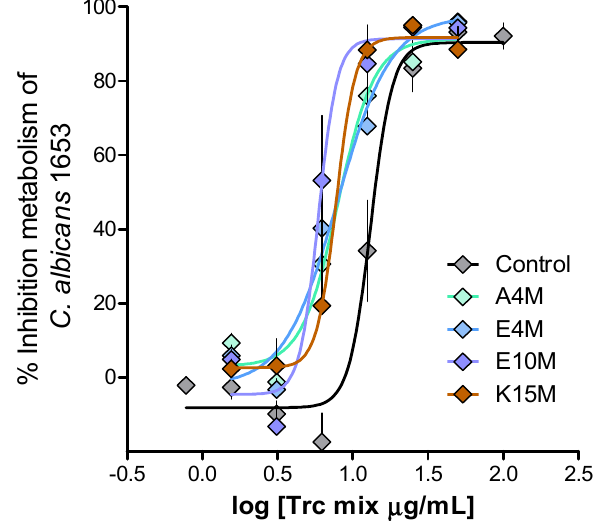
Figure 5. Representative dose-response curves of the Trc mix alone and the selected fresh 1:4 formula- tions. The average of four biological repeats ( n = 16–30 dose-response curves) shows the activity of the Trc mix and its formulation against C. albicans . Each data point depicts the average and the standard error of the mean (SEM), and the curves were fitted with a sigmoidal curve with a variable slope.